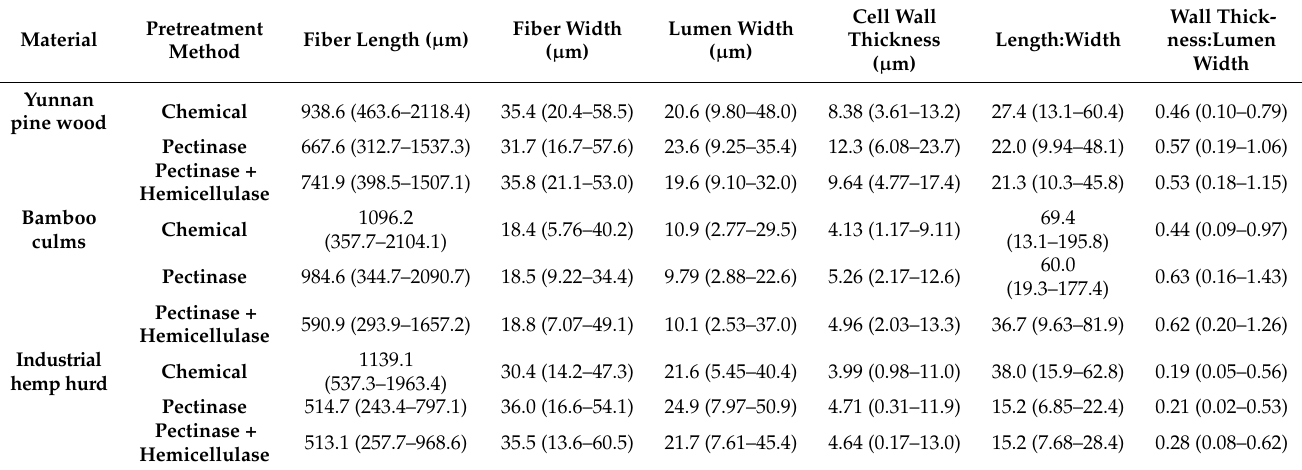
a Values represent means of 100 fibers per material per treatment while figures in parentheses are the